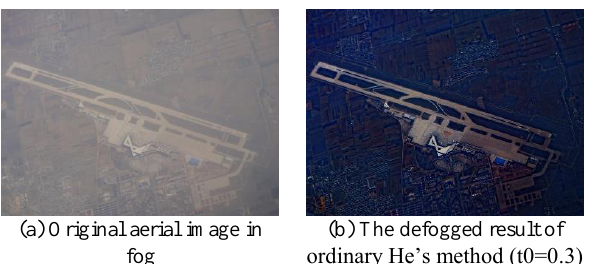
Figure 5. Processing result of third test group